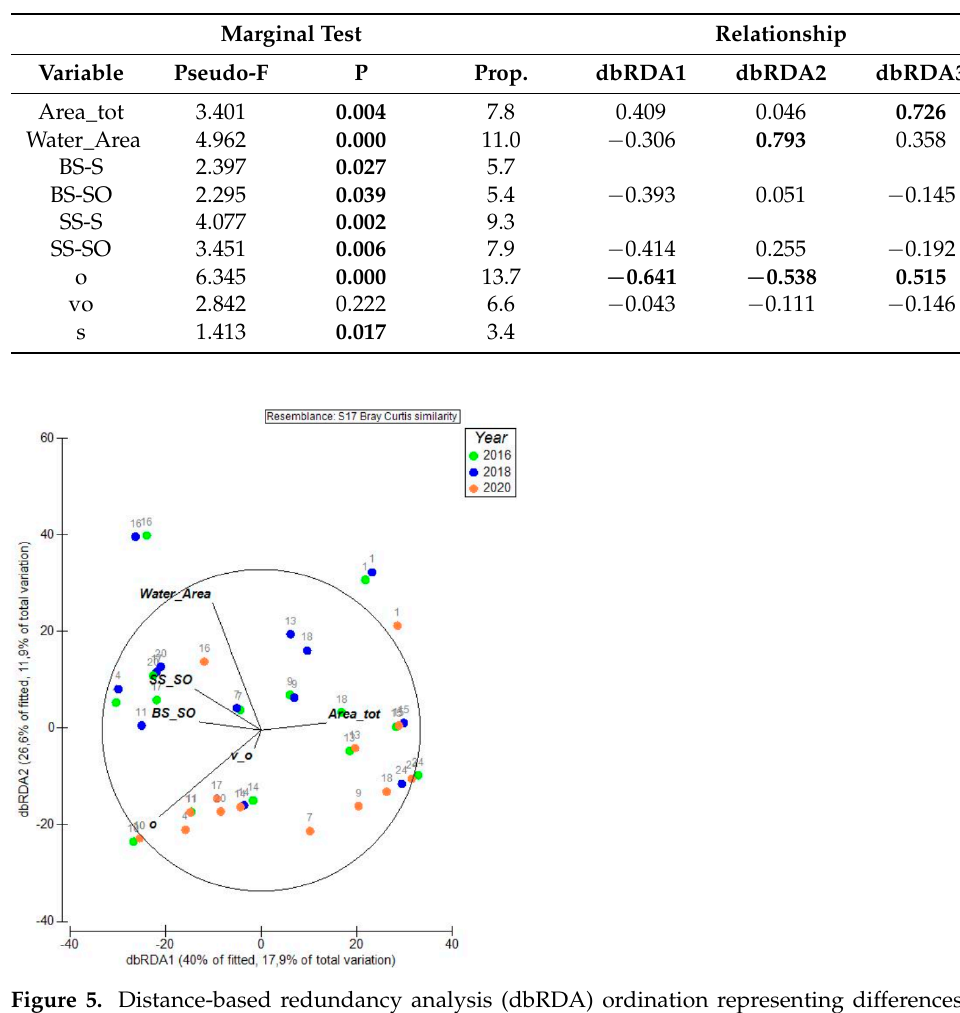
Table 4. Marginal test for environmental variables and relationships between dbRDA coordinate axes and best set of environmental variables identified by a distance-based linear model (DISTLM) stepwise procedure. Area_tot = total kettle hole area, Water_Area = water surface, BS-S = big and shallow storage type, BS-SO = big and shallow shore overflow typ, SS-S = small and shallow storage type, SS-SO = small and shallow shore overflow type, o = oblique, vo = very oblique, s = steep. Pseudo-F = Pseudo-F statistic, P = probability value, Prob. = probability in percent/explained variability. Significant values = bold.